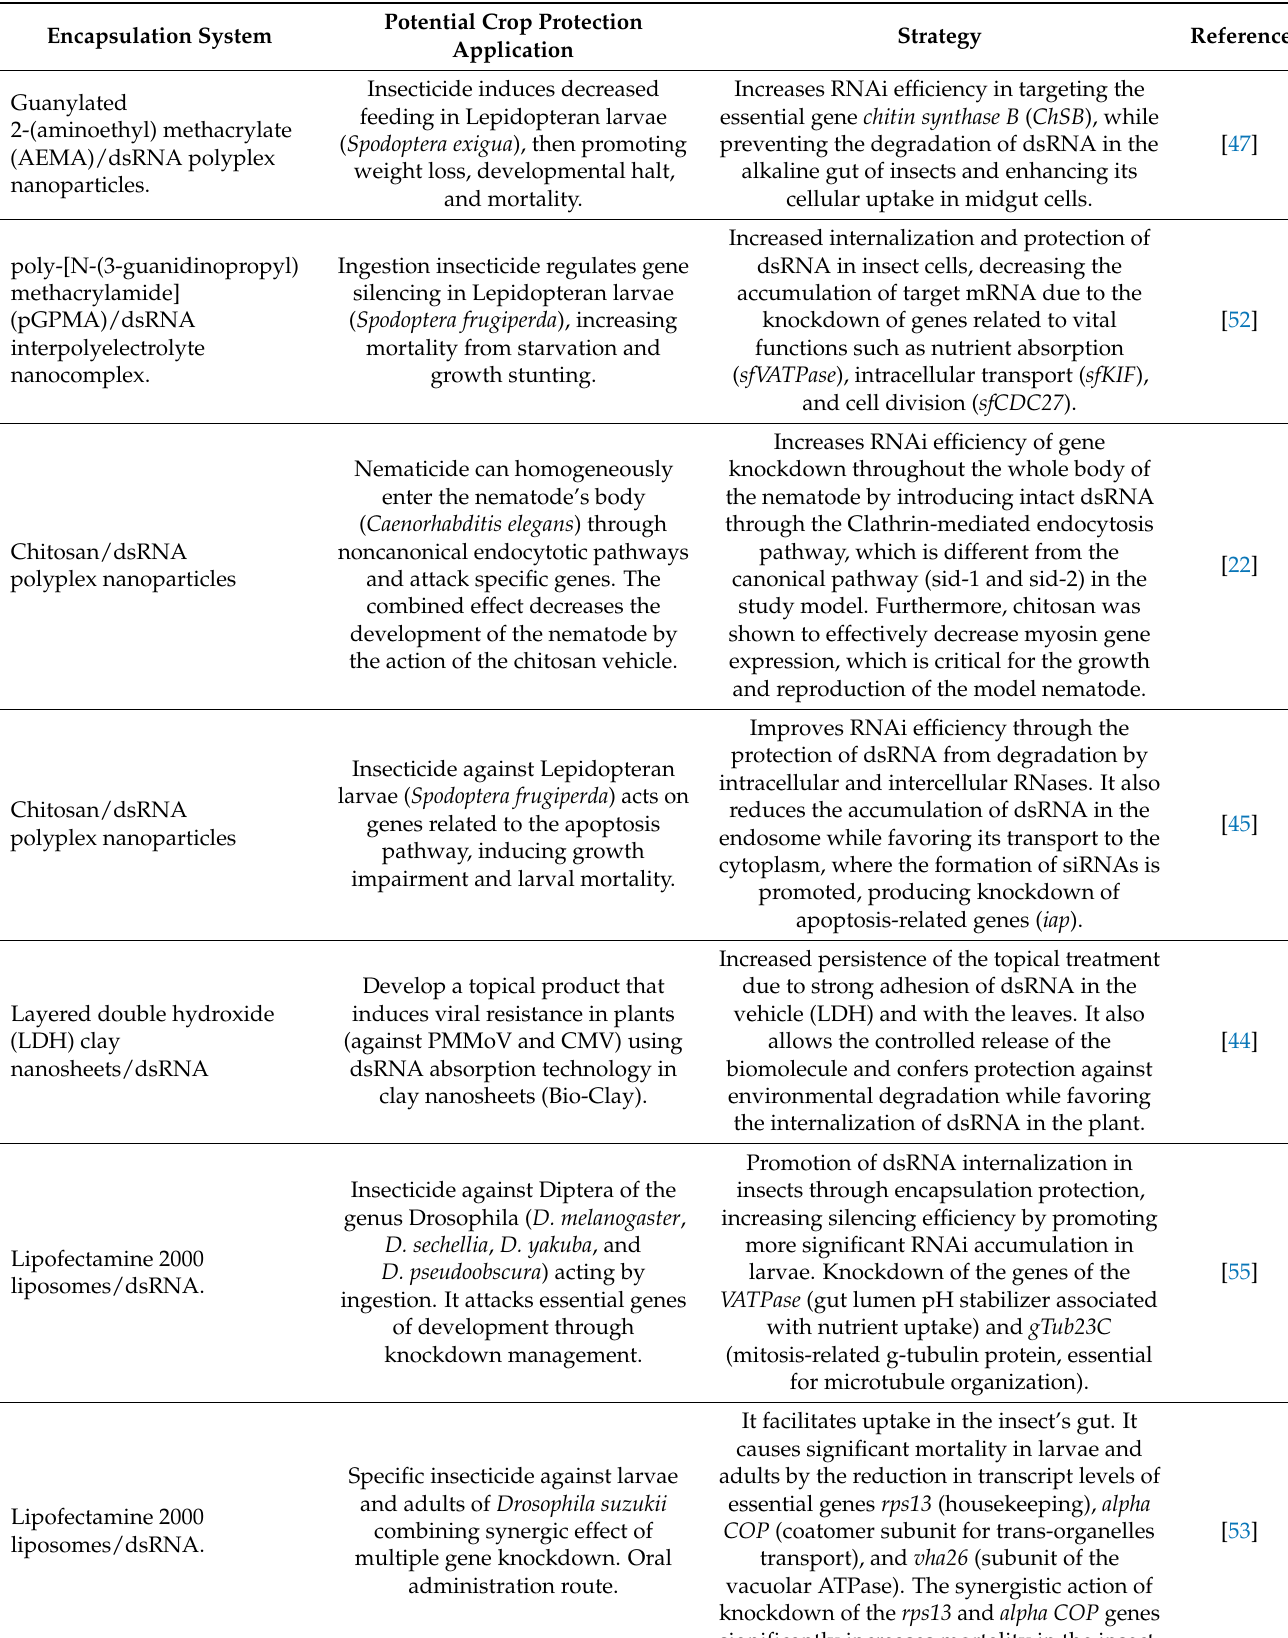
Table 2. Summary of crop protection applications using an encapsulation system for RNAi